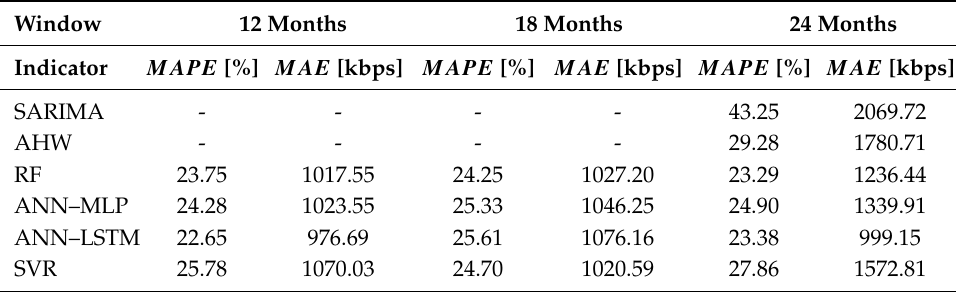
Table 2. Impact of observation window for 3-month horizon.